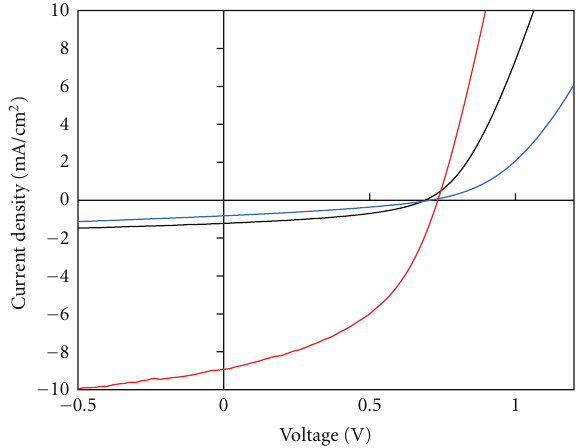
Figure 6: Current-voltage characteristics of bulk heterojunction Table 3: Photovoltaic characteristics of best devices prepared